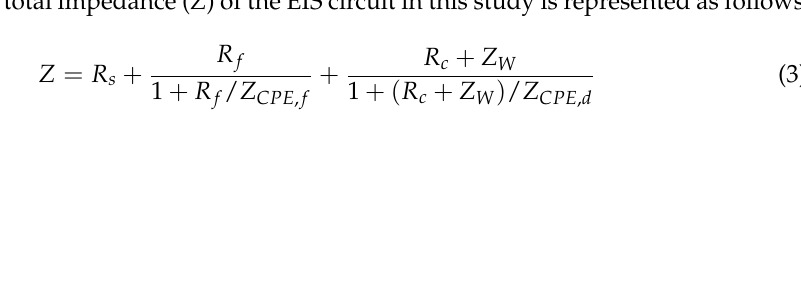
Figure 6. Equivalent electrical circuit models for modelling corrosion of steel in concrete considering electrochemical deposit in concrete.